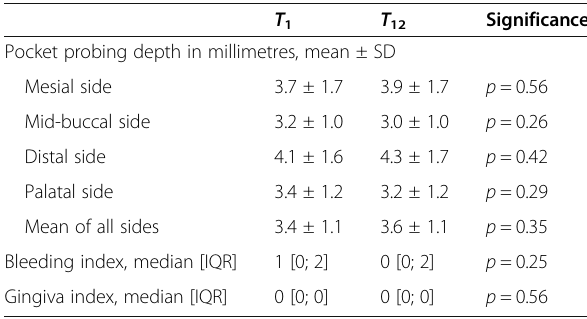
Table 3 Clinical parameters at 1 month ( T 1 ) and 12 months ( T 12 ) after definitive crown placement ( n = 29) T